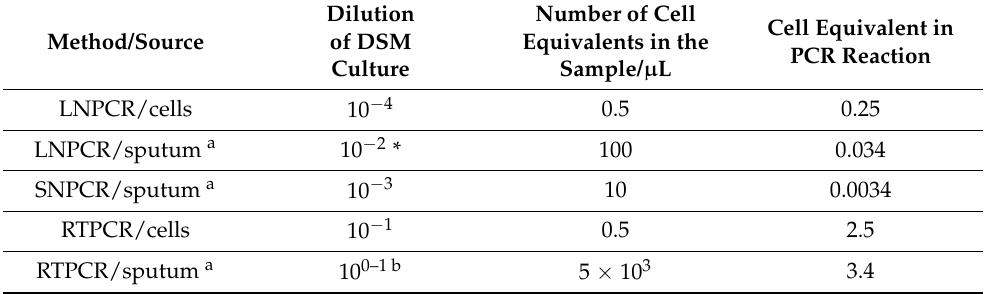
Table 4. Chlamydia pneumoniae detection